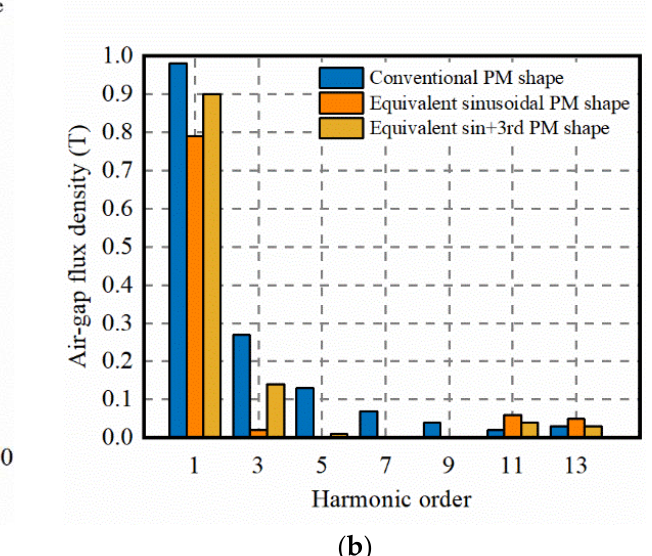
Figure 11. No-load air-gap flux density waveform and harmonic distribution: ( a ) air-gap flux density waveform; ( b ) harmonic distribution.